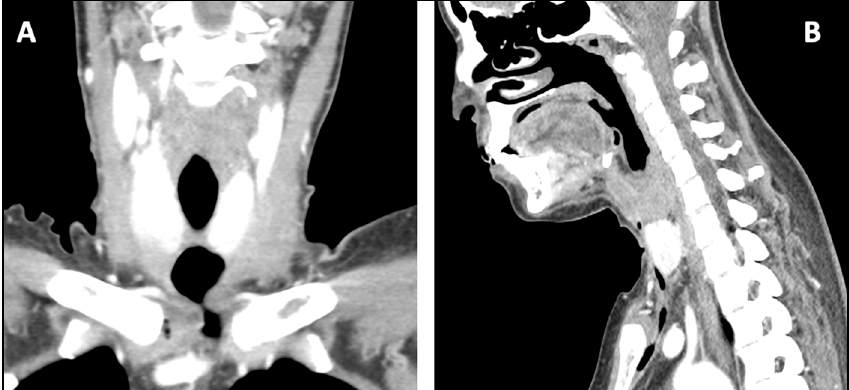
Figure 3. CT scan performed 15 days after surgical drain shows the healing in coronal view ( A ) and in sagittal view ( B ).